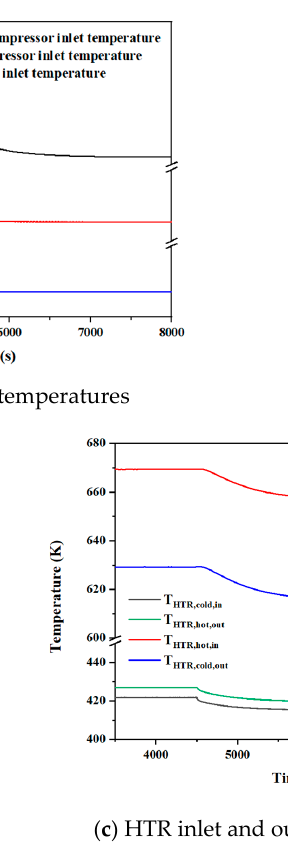
Figure 9. Response curves of main parameters with MC inlet temperature disturbance.